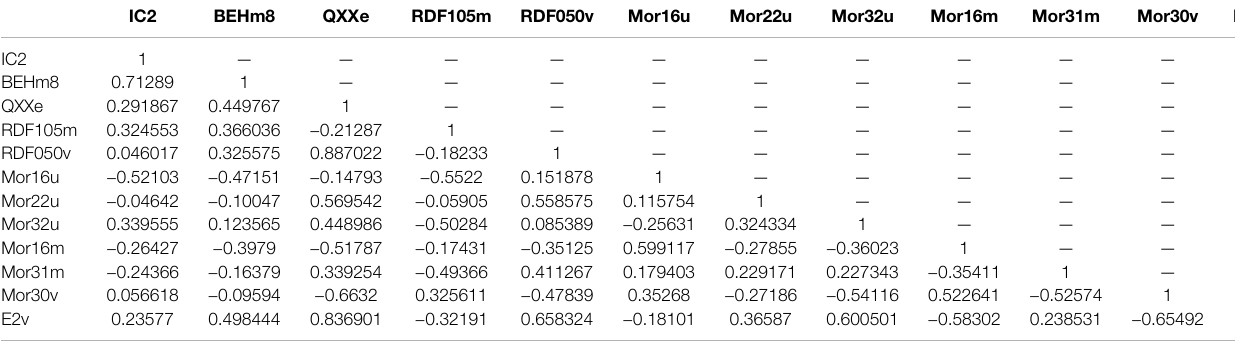
TABLE 4 | Correlation matrix for the twelve chosen descriptors by means of Stepwise − MRL. IC2 BEHm8